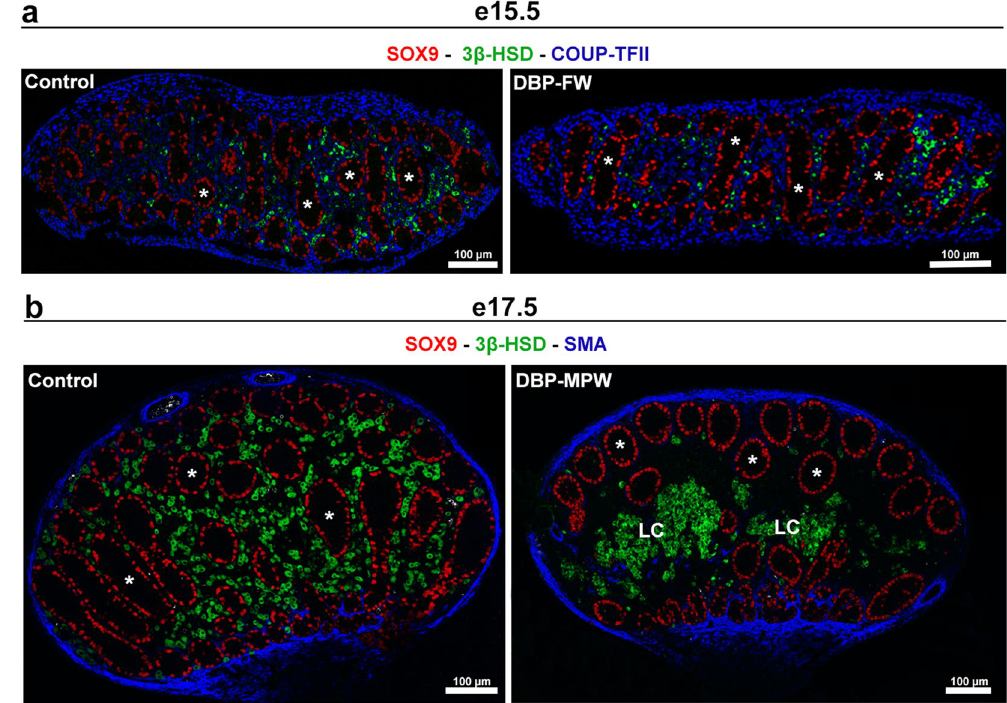
Figure 3. Seminiferous cord formation occurs normally after exposure to DBP during either the FW or the MPW. Sections in ( a ) were triple immunostained for SOX9 (red, Sertoli cells), 3 β -HSD (green, Leydig cells) and COUP-TFII (blue, mesenchymal cells) whereas sections in ( b ) were immunostained for SOX9 (red, Sertoli cells), 3 β -HSD (green, Leydig cells) and smooth muscle actin (blue). Two days after the beginning of DBP treatment (e15.5, DBP-FW treatment; e17.5, DBP-MPW treatment), the seminiferous cords are normally formed ( * ) in the testis and only occasional ectopic Sertoli cells are seen, comparable to the situation in controls (see Fig. 4). Note the abnormal central Leydig cell aggregation (LC) at e17.5 in the testis of the DBP-MPW exposed rat, which constitutes the first sign of dysgenesis.